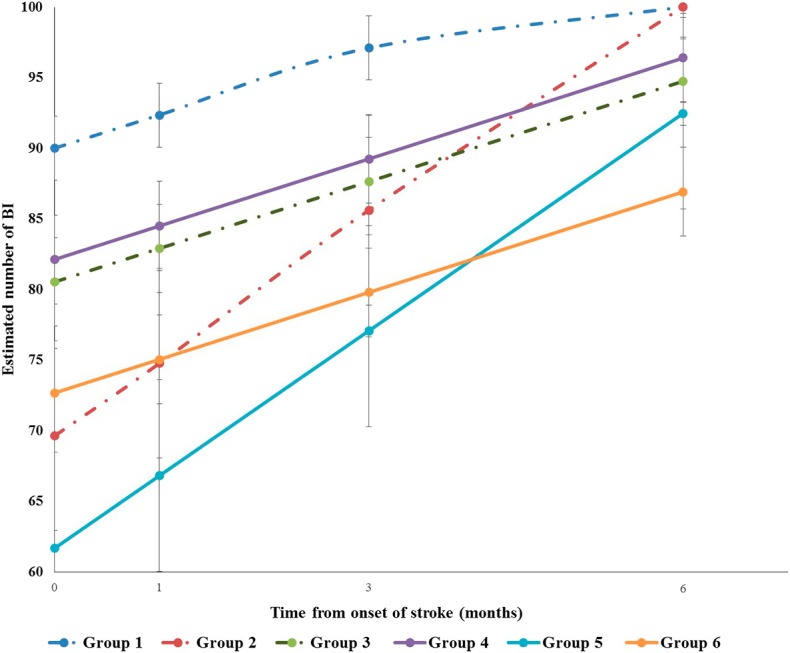
Trajectories of Barthel Index (BI) by baseline cognitive function, premorbid disability and rehabilitation. Group1 normal cognition without premorbid disability without rehabilitation in 1month after onset. Group2 normal cognition without premorbid disability with rehabilitation in 1month after onset. Group3 normal cognition with premorbid disability without rehabilitation in 1month after onset. Group4 cognition impairment without premorbid disability without rehabilitation in 1month after onset. Group5 cognition impairment without premorbid disability with rehabilitation in 1month after onset. Group6 cognition impairment with premorbid disability without rehabilitation in 1month after onset.